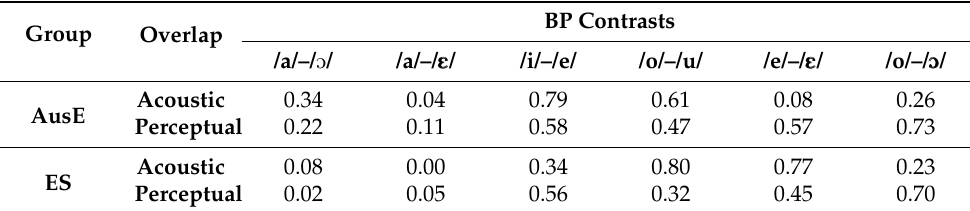
Table 6. Acoustic and perceptual overlap scores for AusE and ES listeners expressed as proportions.